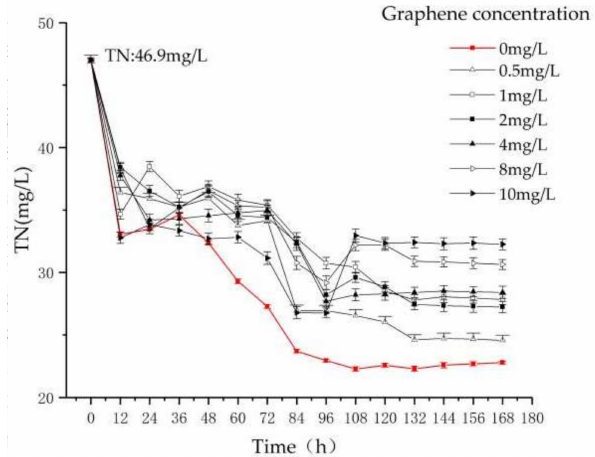
Figure 3. The variation of TN as a function of reaction time and graphene